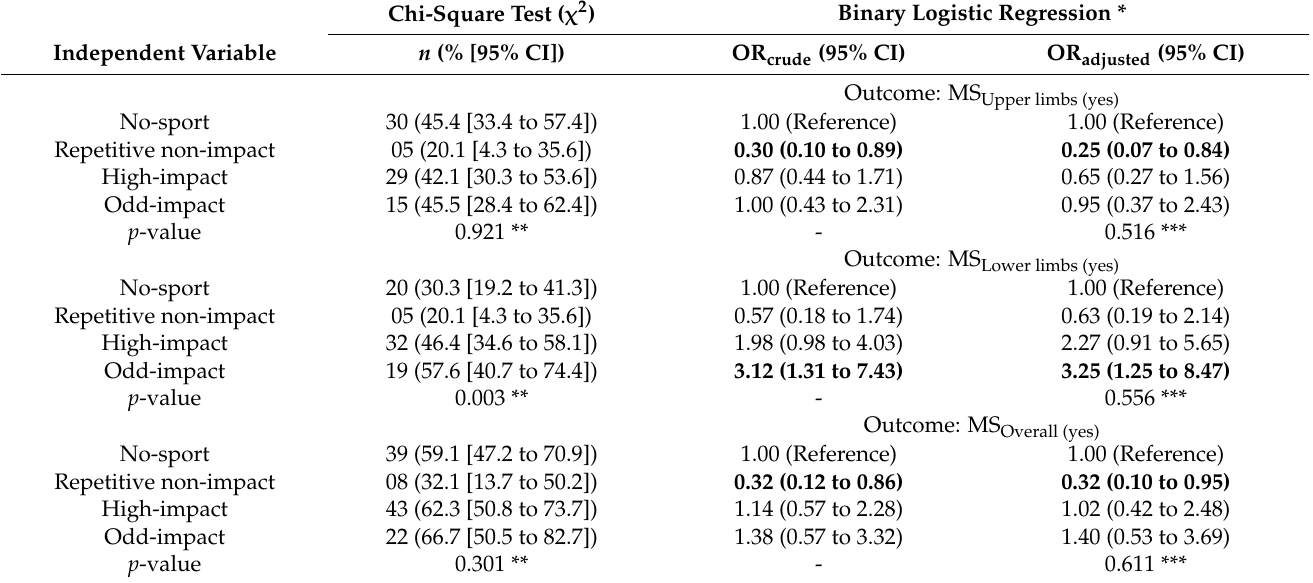
Table 3. Association between musculoskeletal symptoms and sports participation among adolescents (ABCD—Growth Study; n =